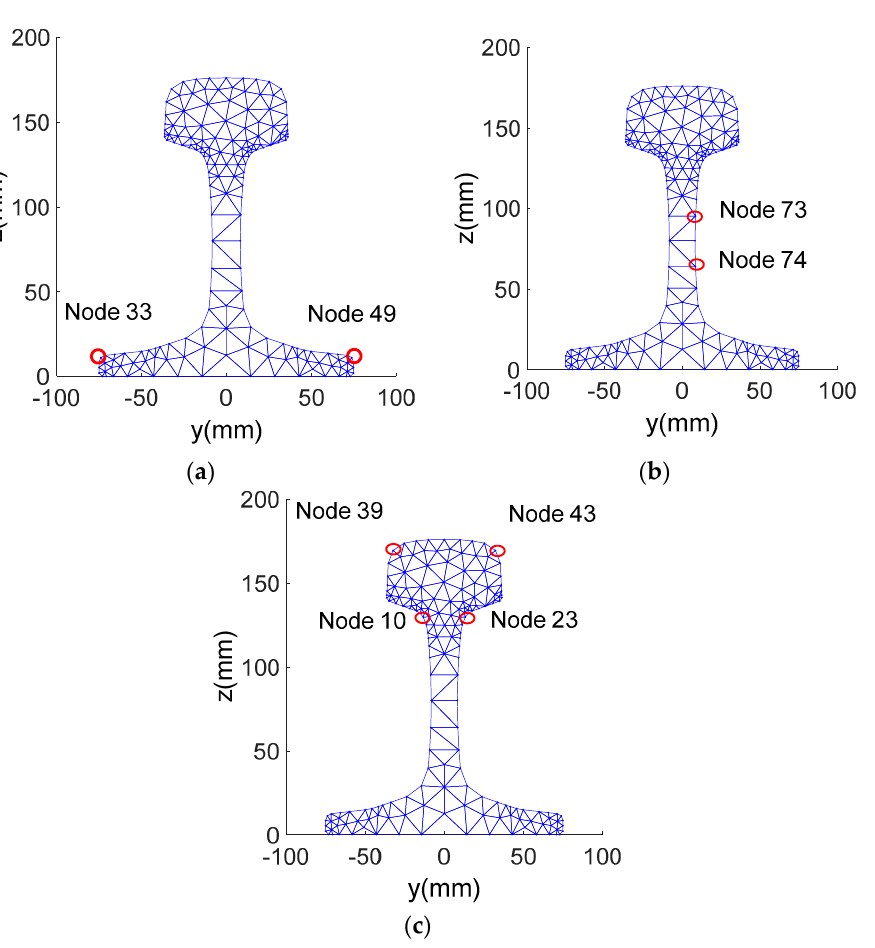
Figure 6. Excitation nodes of modes. ( a ) Excitation node of mode 1; ( b ) excitation nodes of mode 3; ( c ) excitation nodes of mode